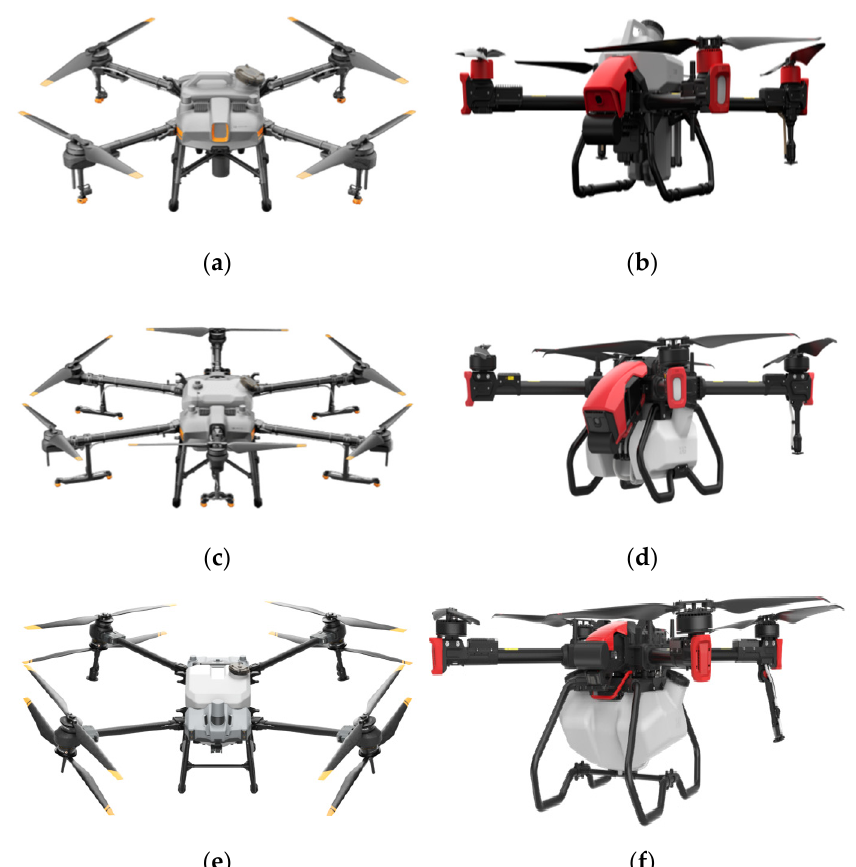
Figure 1. T series plant protection UAV and P series plant protection UAV. ( a ) DJI—T10. ( b ) XAG—P40. ( c ) DJI—T20. ( d ) XAG—P80. ( e ) DJI—T40. ( f ) XAG—P100.